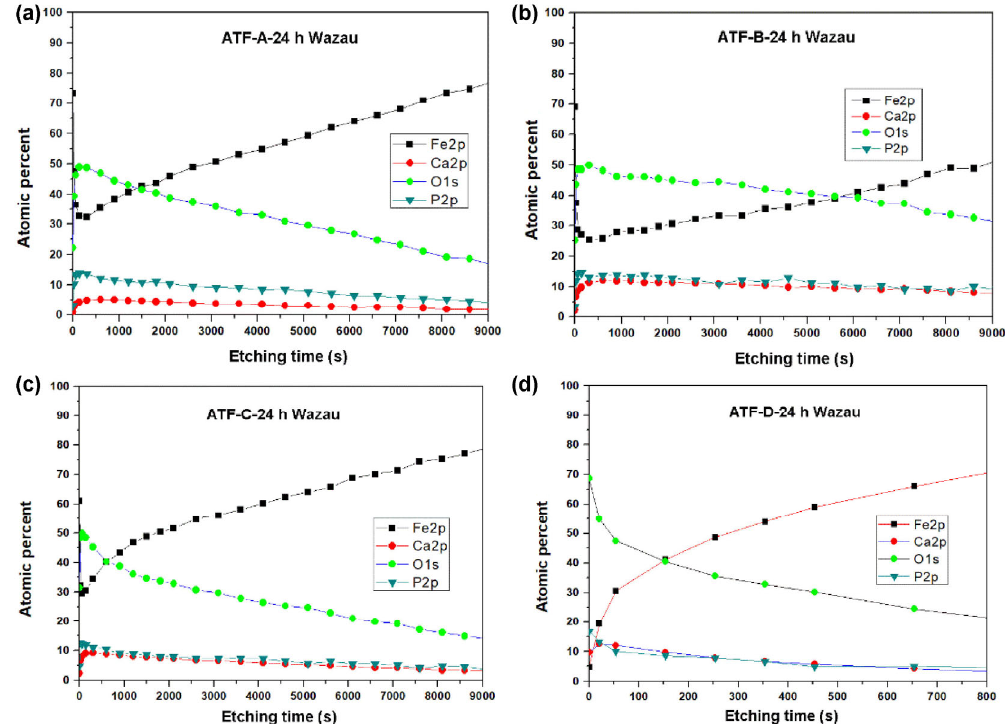
Fig. 13 XPS depth profile of the post-test (24 h durability) steel surface tribofilms for ATFs A, B, C, and D (etching rate = 0.1